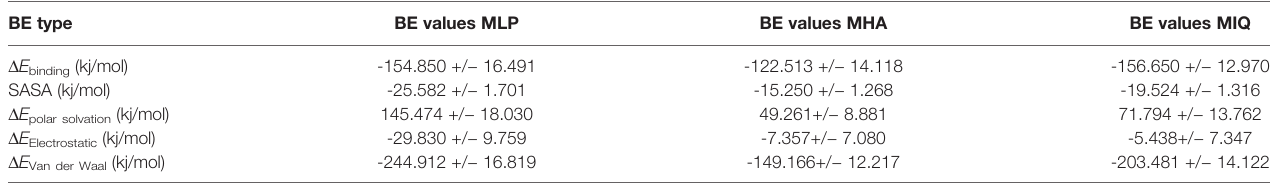
TABLE 4 | Binding free energy for Main protease complexes with standard inhibitor and lead phytochemical – bound complexes. BE type